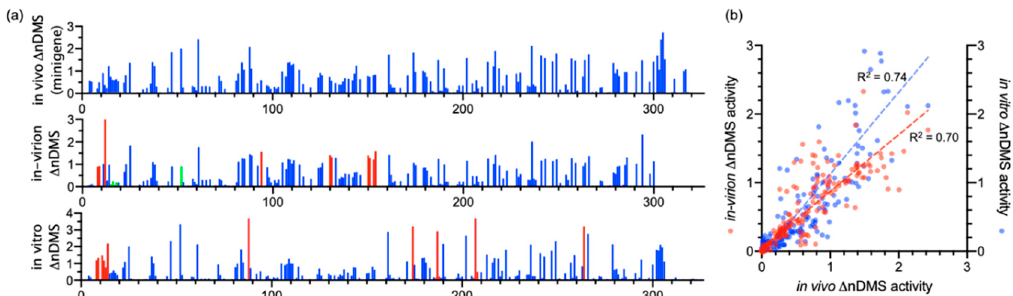
Figure 2. ( a ) The in vivo minigene, in-virion, and in vitro normalized dimethyl sulfate (DMS) activity ( Δ nDMS) profiles of the SARS-CoV-2 3 ′ UTR. Compared to the in vivo minigene, the significantly higher or lower Δ nDMS activities are labeled in red and green, respectively (> 95% confidence in Z -factor test and > 1.5-fold Δ nDMS activity change, see Table S1 for details). The activity data are not available for the primer-binding regions, i.e., nts 319–327, 302–327, and 311–327 in the in vivo minigene, in-virion, and in vitro DMS-MaPseqs, respectively. ( b ) The correlations between the in vivo minigene and in-virion or in vitro Δ nDMS activities. The out-of-range data points are omitted in the figure. The in vitro DMS-MaPseq was re-analyzed using the data from Ref. [12] with the ShapeMapper2 pipeline (see Methods).